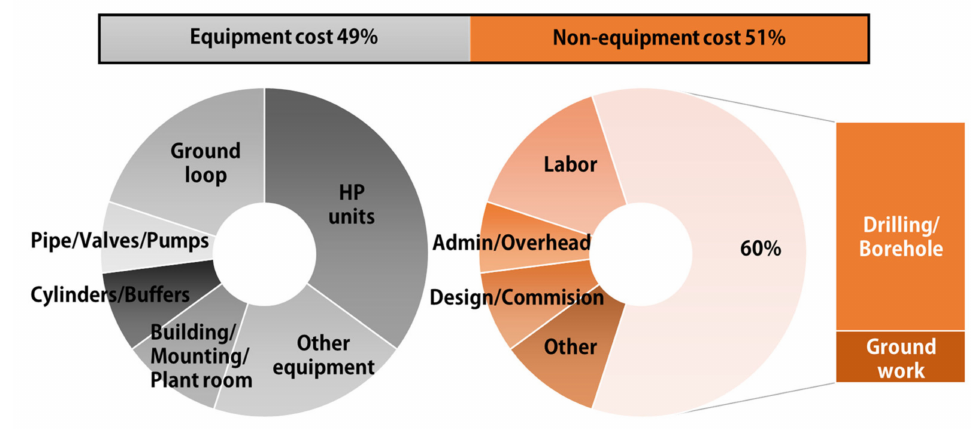
Figure 2. Cost breakdown into equipment & non-equipment costs for a GSHP